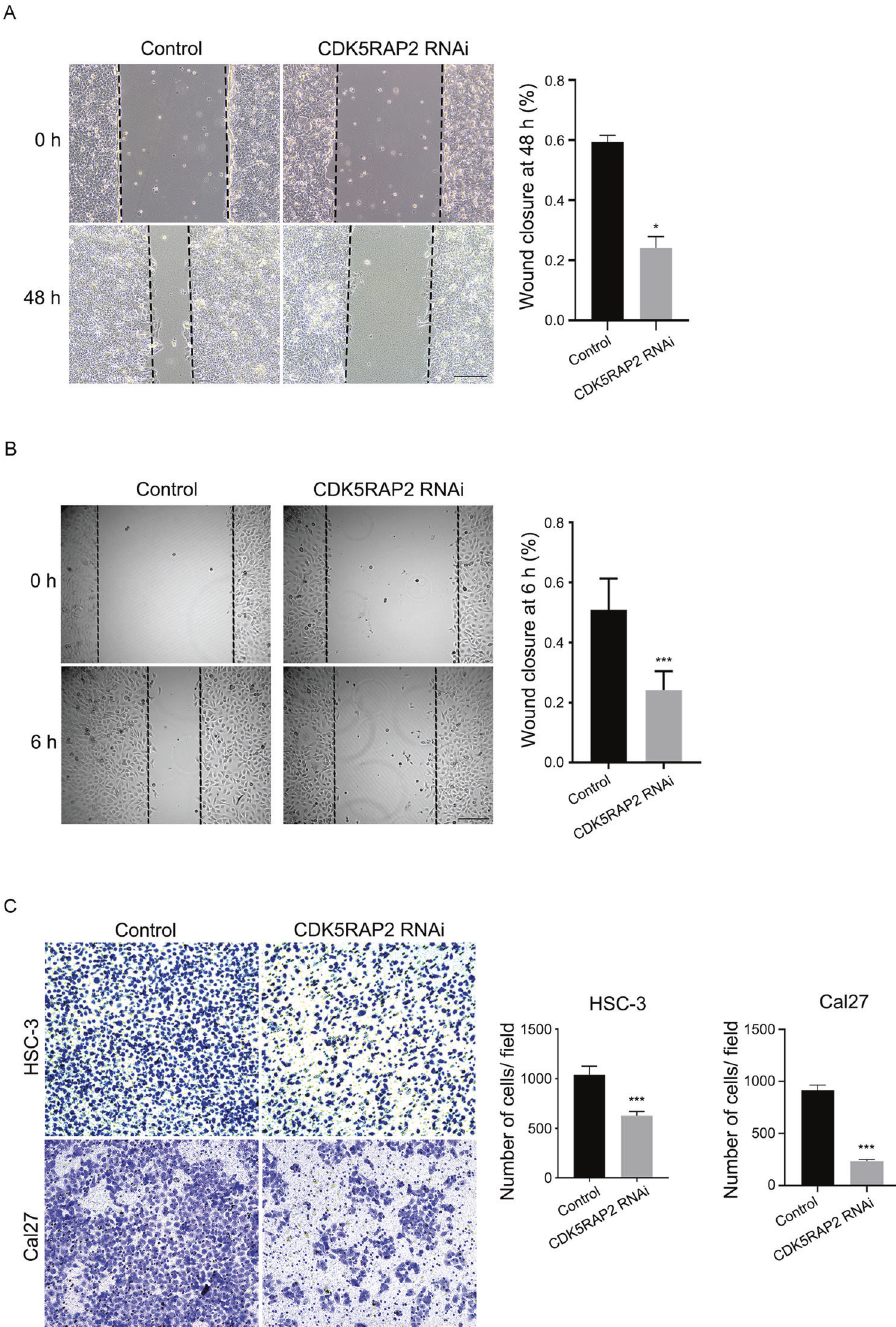
Fig. 4 CDK5RAP2 downregulation inhibits OSCC cell migration. A , B Wound-healing assay was performed using Cal27 A and HSC-3 B stable cells. Representative images are shown. Ratios of wound closure at 48 h or 6 h were quanti fi ed. C Transwell migration assay was performed using stable cells. Representative images are shown. The migrated cell number per fi eld was quanti fi ed. Data are presented as means ± SD; * P < 0.05, *** P < 0.001, two-tailed Student ’ s t -test. Scale bars, 200 μ integrin-mediated cell-substrate adhesion, and the spindle angle is the angle between the substrate plane and the spindle pole axis (Fig. 6A). Under a confocal microscope, we acquired Z-stack images of metaphase cells and used γ -tubulin immunostaining to visualize spindle poles (Fig. 6B). Our measurements revealed that CDK5RAP2 depletion signi fi cantly increased the spindle angle compared to that in control cells (Fig. 6B). These results binding protein EB1, thus regulating microtubule dynamics and indicate that CDK5RAP2 is involved in the control of spindle cell motility [38 – 40]. In this study, we have uncovered a previously orientation.